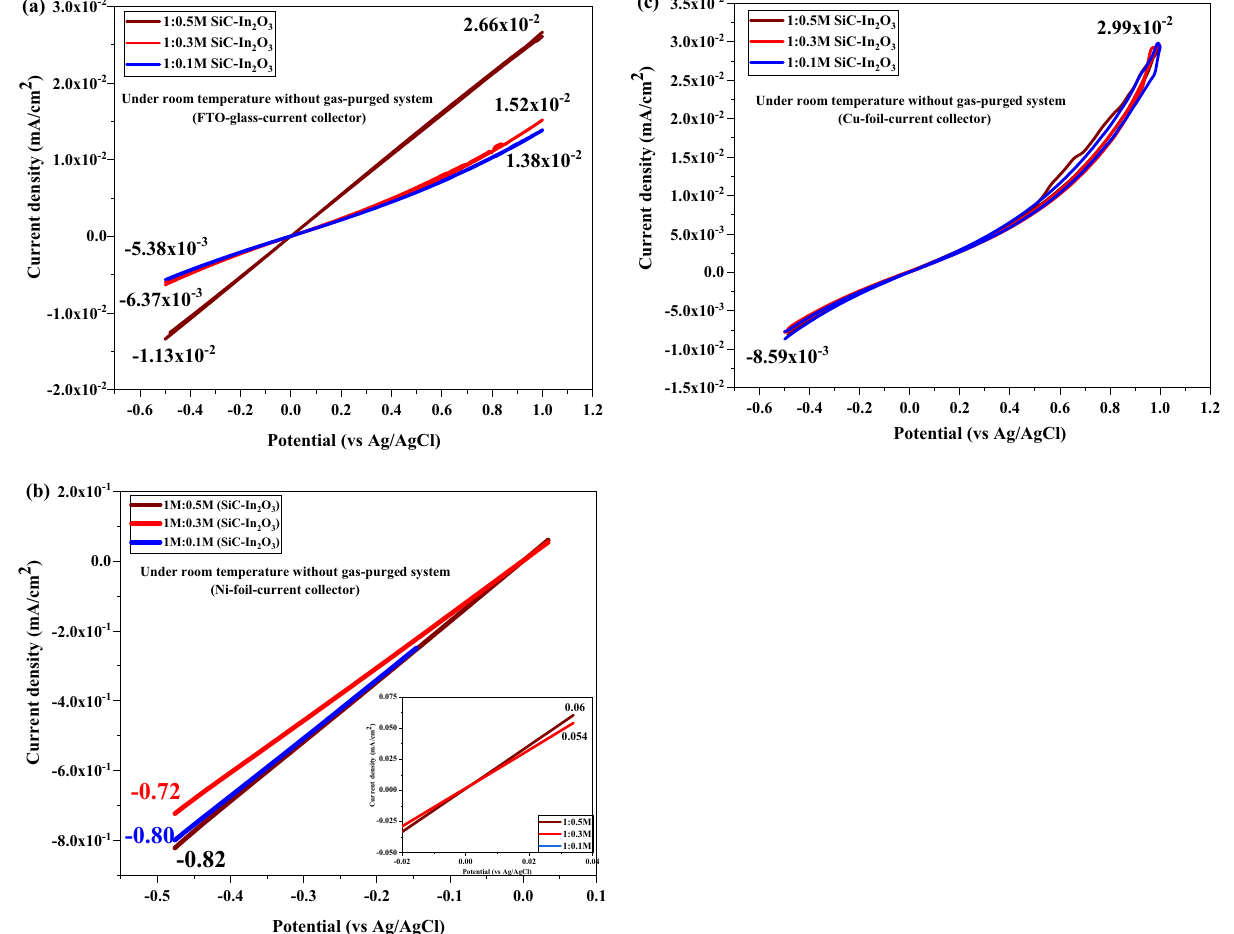
Figure 9. CV test of the as-prepared electrode in room temperature (25 °C) without gas-purging conditions on ( a ) FTO glass, ( b ) Ni foil, and ( c ) Cu foil current